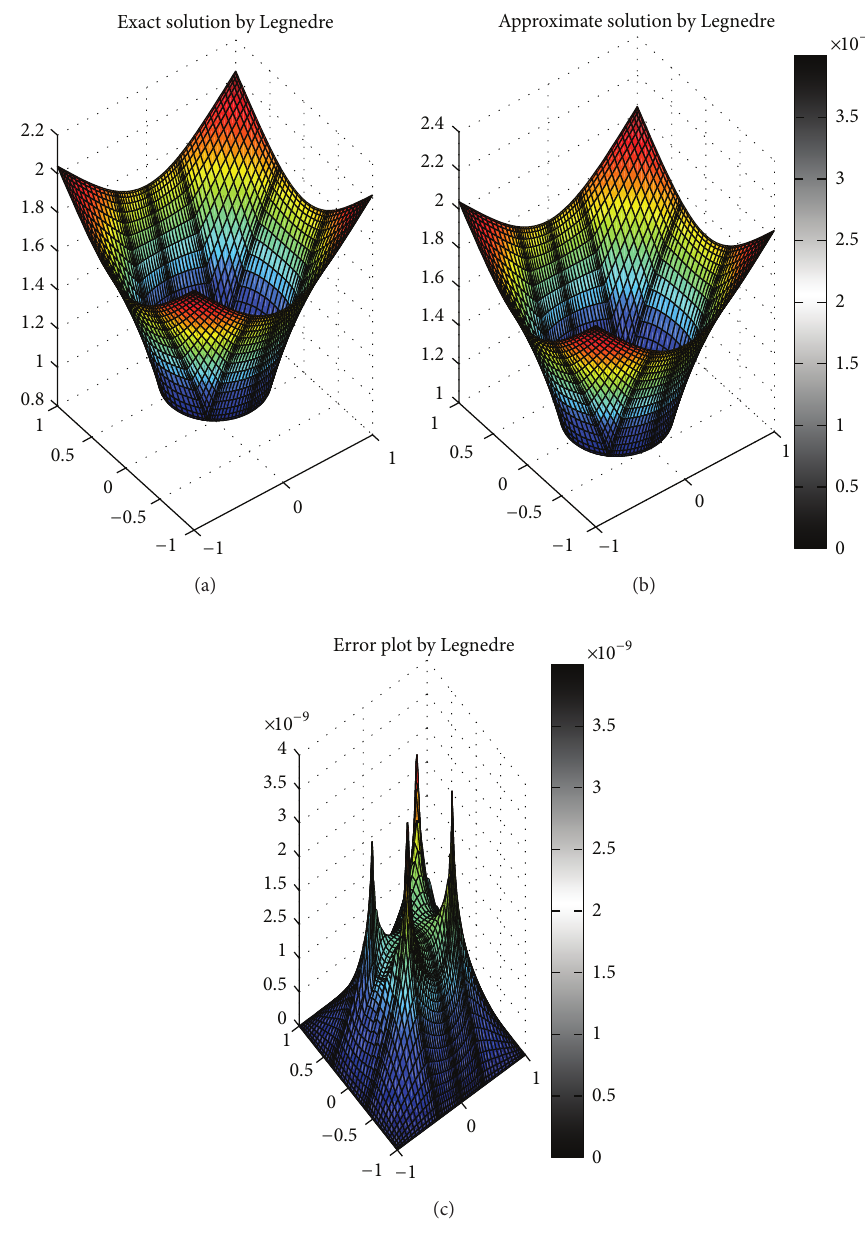
Figure 4: Exact solution, approximation solution, and its error for 𝑁 = 18